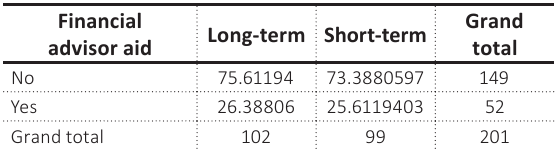
Table 4. Expected frequencies of the impact of an advisor on short and long-term